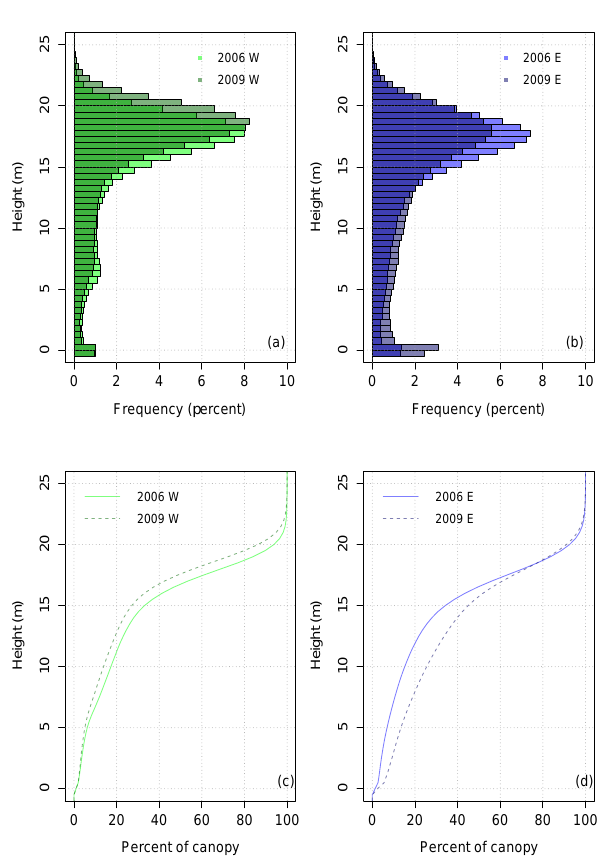
Figure 6. Histograms of canopy top height (m) derived from aerial lidar for the east sector (blue bars) and west (green bars) for (a, b) 2006 and 2009; cumulative frequency of canopy top height for (c) west sector in 2006 and 2009 and (d) east sector in 2006 and 2009 at the Straits Inclosure, Alice Holt